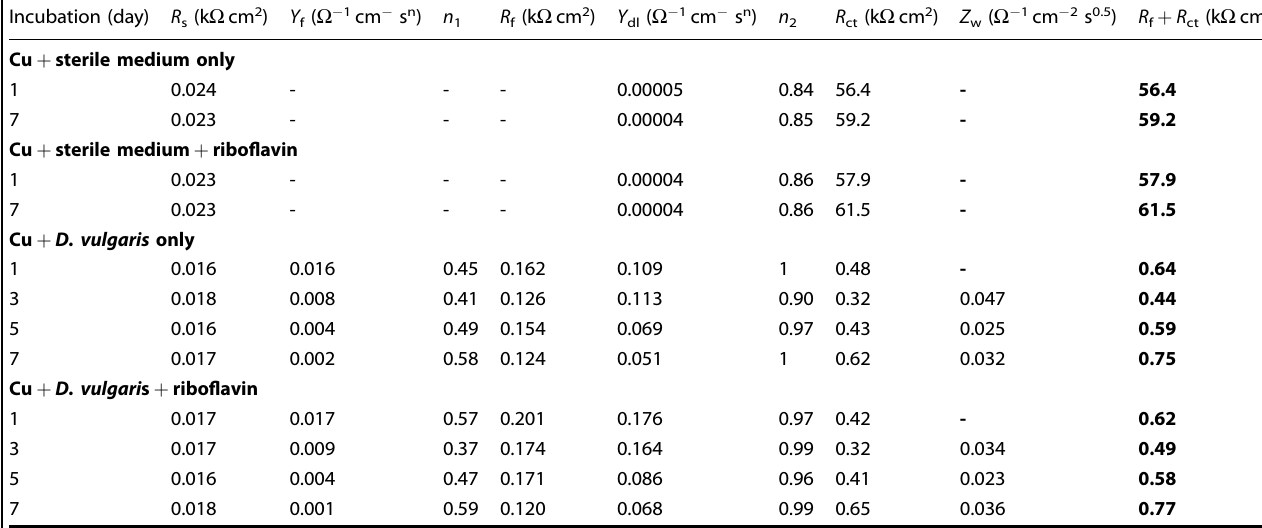
Table 1. Fitted electrochemical parameters from EIS data of Cu.